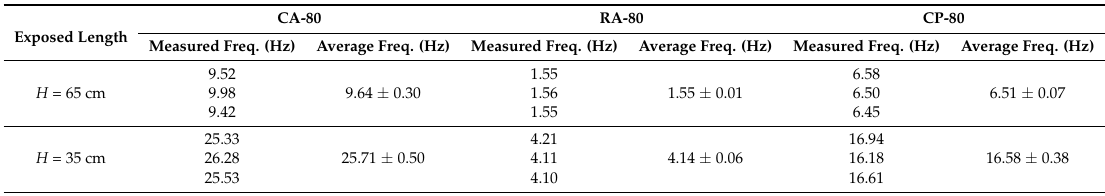
Table 5. Repeatability analysis in dry